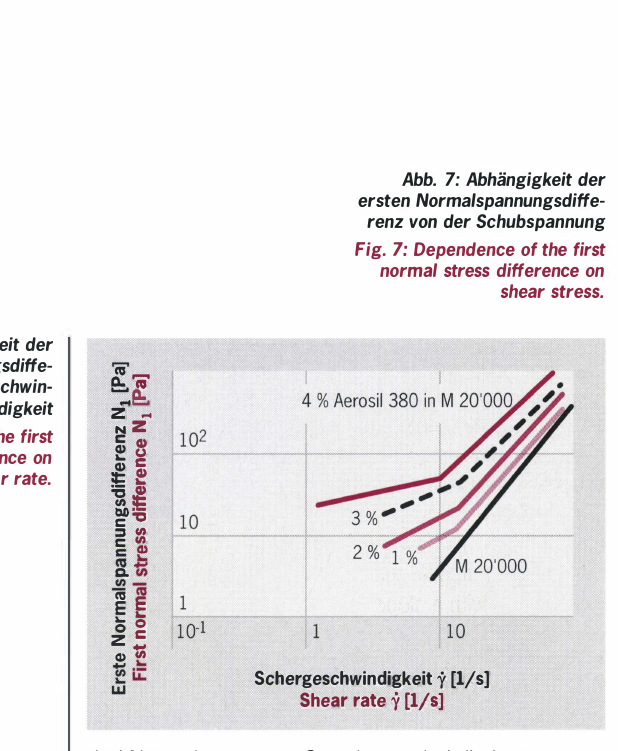
Fig. 7: Dependence of the first normal stress difference on shear